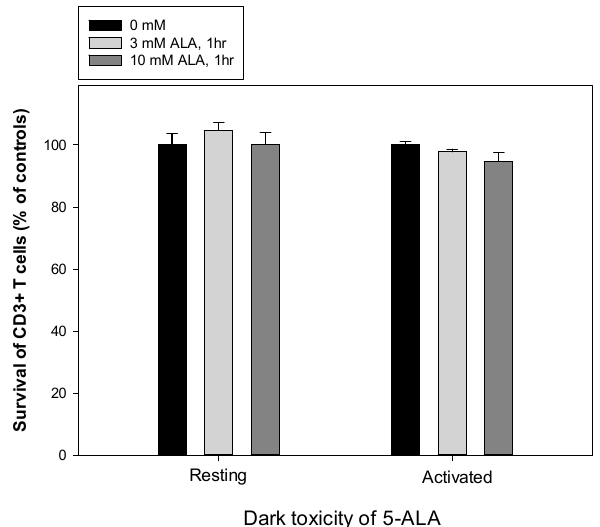
450–490 nm (peak at 475–485 nm) excitation BP filter and a > 515 nm emission LP filter.